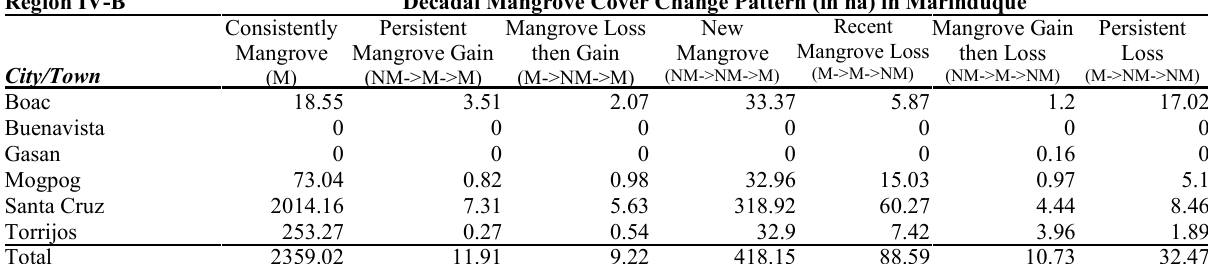
Table 7. Decadal Mangrove cover change pattern (in ha) in Marinduque. Note: M symbolizes the existence of mangroves, NM otherwise.